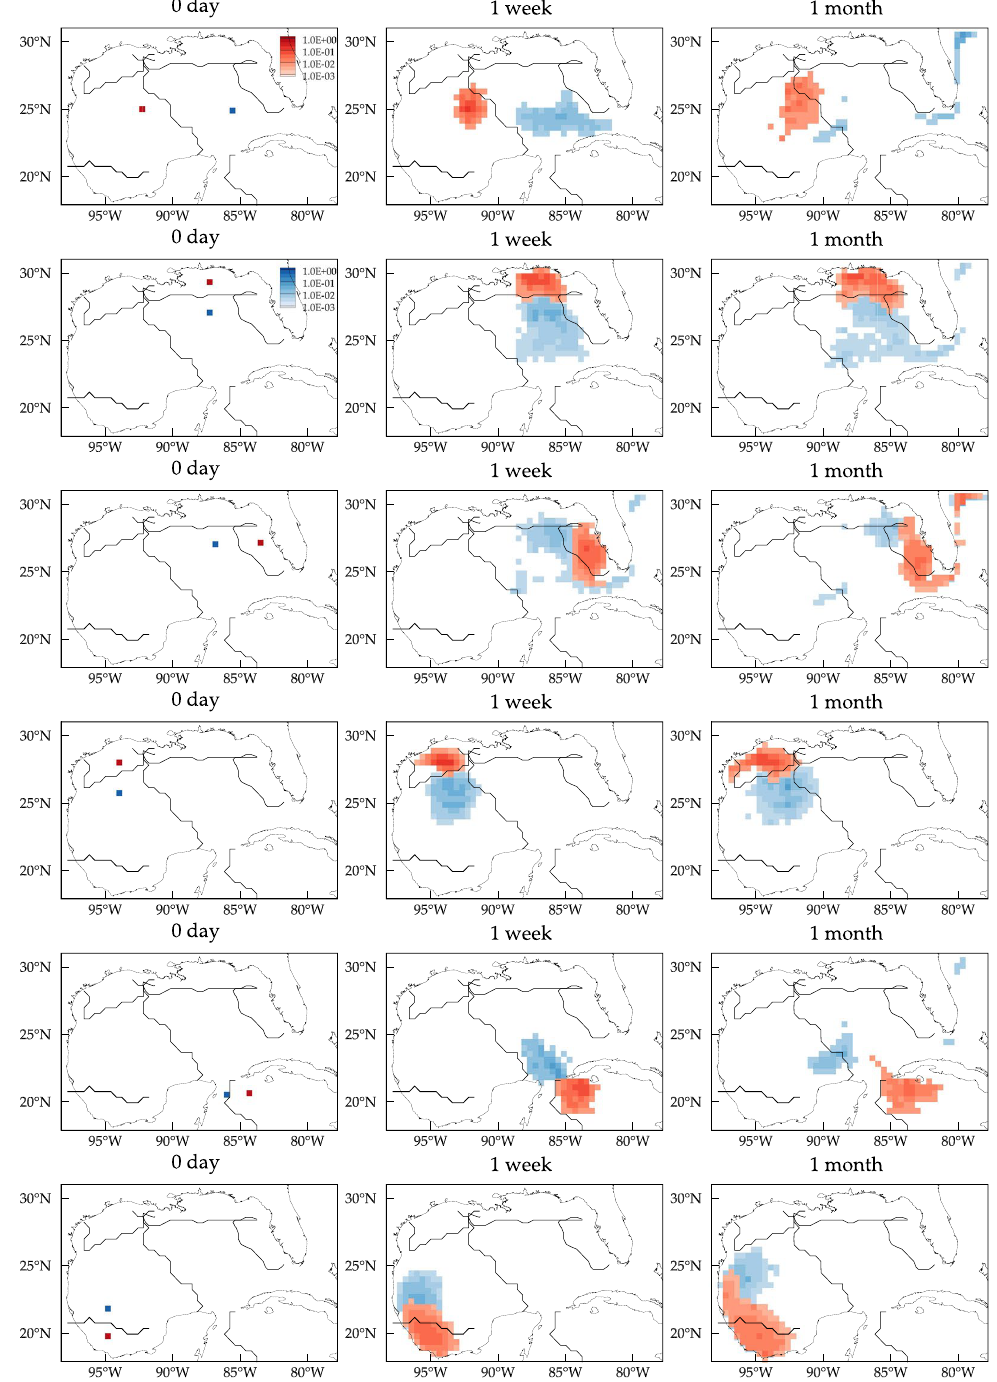
Figure 7. Forward evolution under the action of the transition matrix P of tracers released at various localized regions with dynamical geographic divisions overlaid. The tracer concentration is normalized by the mean concentration. Computations carried using Matlab R2017a (http://www.mathworks.com/) and visualization using Tecplot 360 2016 R2